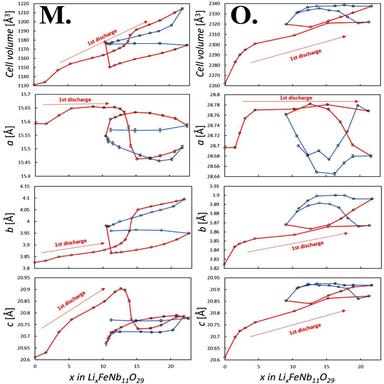
Refined lattice parameters and cell volume during the operando XRD measurements at C/10, for monoclinic and orthorhombic FeNb11O29. Red/blue lines connect the refined lattice parameters during discharge/charge.